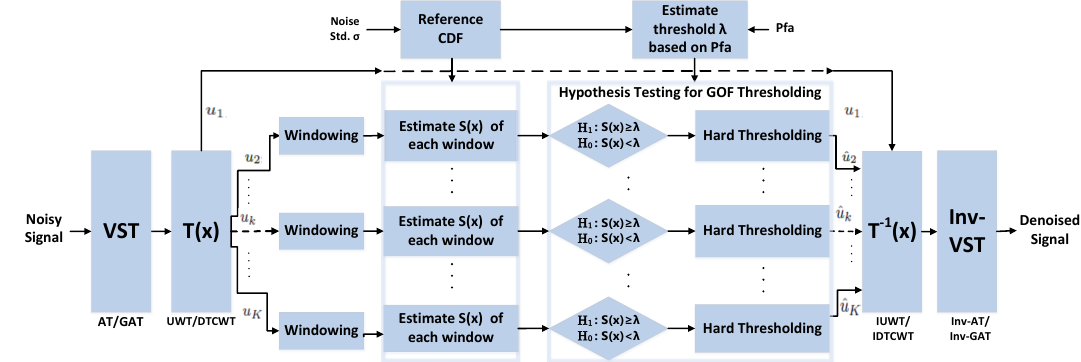
Figure 5. Block diagram of the proposed framework for Poisson and Poisson–Gaussian denoising using detection